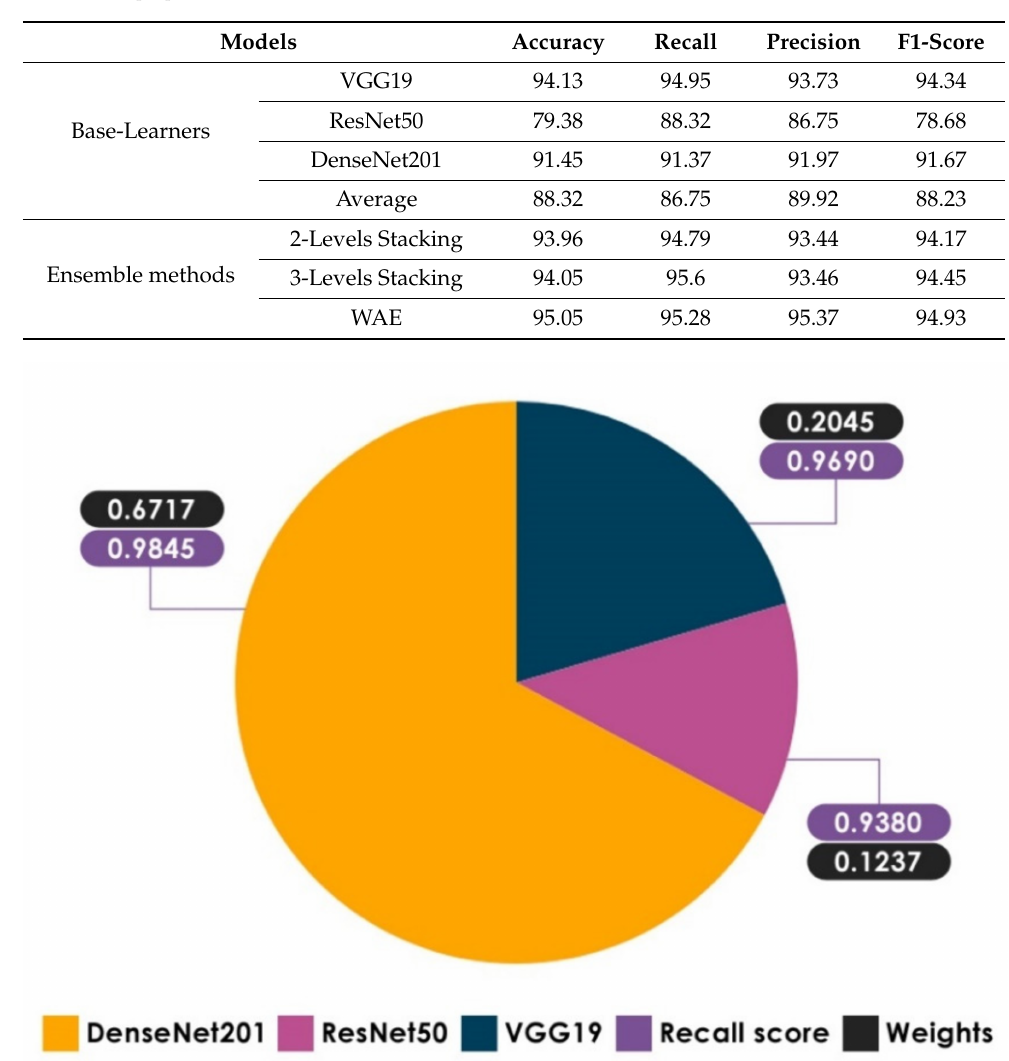
Figure 18. The optimal weights received for the Base-Learners based on the performance of the recall score function on the SARS-CoV-2 CT-scan dataset [42] (note that the weights range between 0 and 1). Precision is defined as the Positive Predictive Rate (PPR) and it is useful in limiting the spread of COVID-19 infection. Based on precision results, it can be noted that